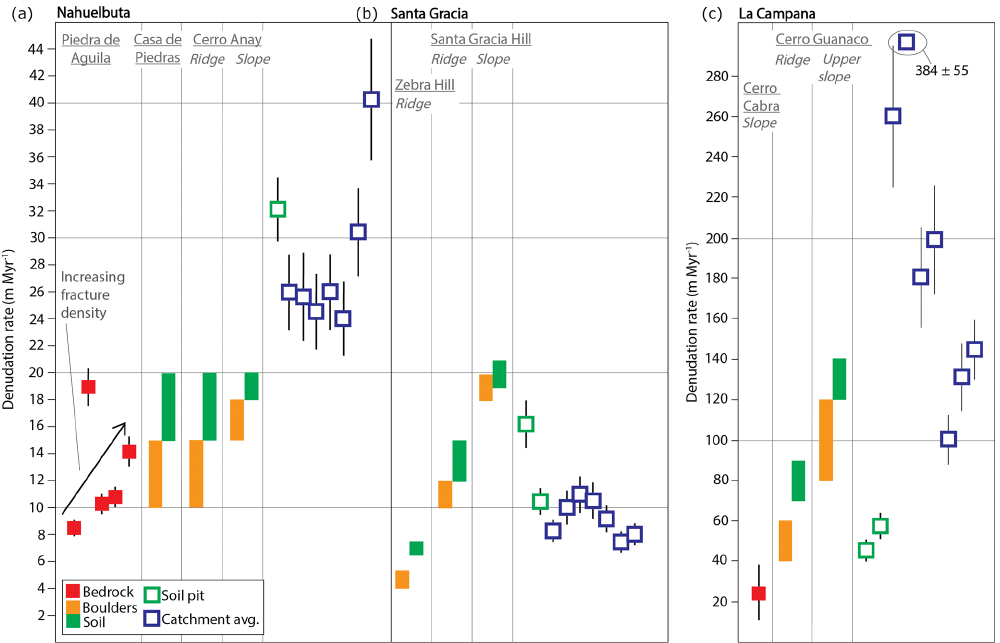
Figure 8. Overview of new and previously published denudation rates (data from this study are shown by solid symbols and previously published data are shown by hollow symbols). Soil pit data are from Schaller et al. (2018), and catchment average data are from van Dongen et al. (2019). Catchment average denudation rates from various sediment grain sizes (from left to right for each field site: 0.5–1, 1–2, 2–4, 4–8, 8–16, 16–32, and 32–64mm). Bedrock denudation rates are calculated using the CRONUS online calculator v2.3 (Balco et al., 2008). Boulder and soil denudation rates are estimated using our model and reflect the most plausible denudation rates as described in Sect. 5.1.2. Denudation rates for each location within a field site are separated by thin gray bars, and locations are labeled at the top of the chart. Samples that were not included in the model (one sample from Nahuelbuta and three samples from La Campana) are also not included